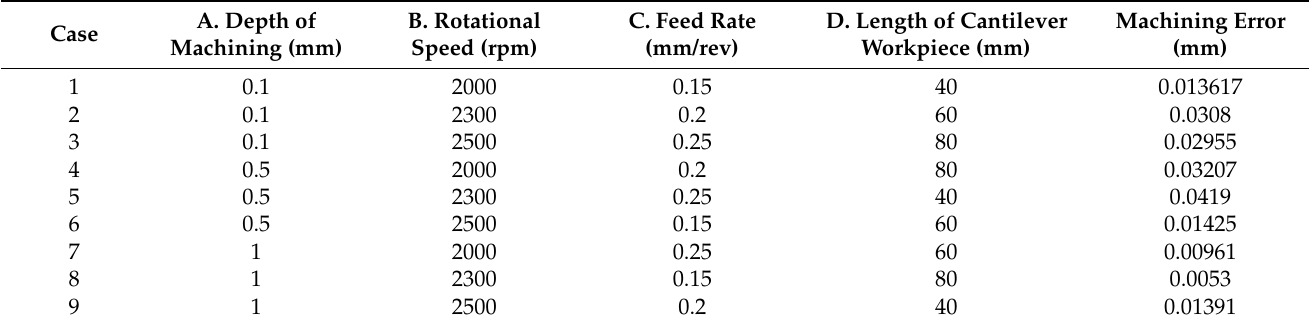
Table 2. Factor and standard. Experimental results by L9 orthogonal array.